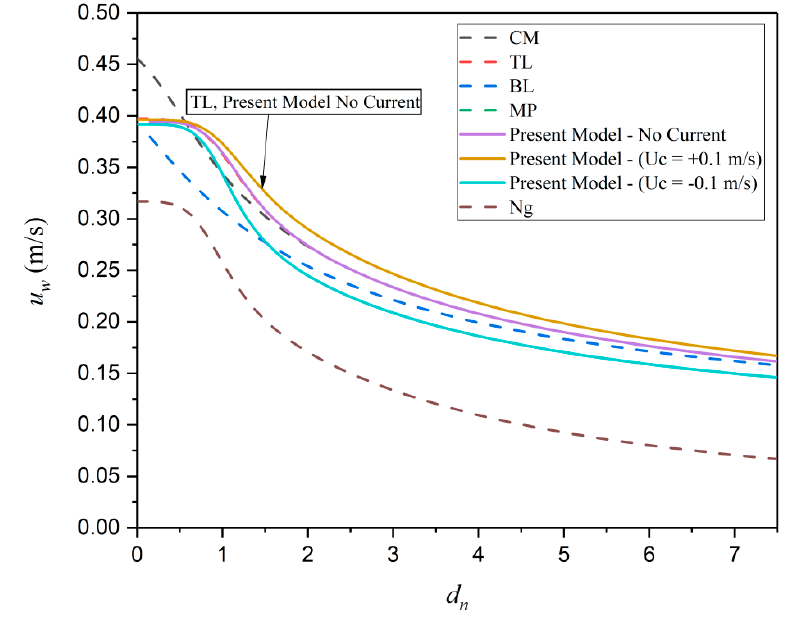
Figure 9. Water velocity ( y = − 0.5 h ) versus dimensionless mud thickness, T = 1.4 s; h = 0.0381 m; ν = 0.0000026 m 2 / s; ν = 0.0026 m 2 / s; ρ = 859.3 kg / m 3 ; ρ = 1504 kg / m 3 . w m w m